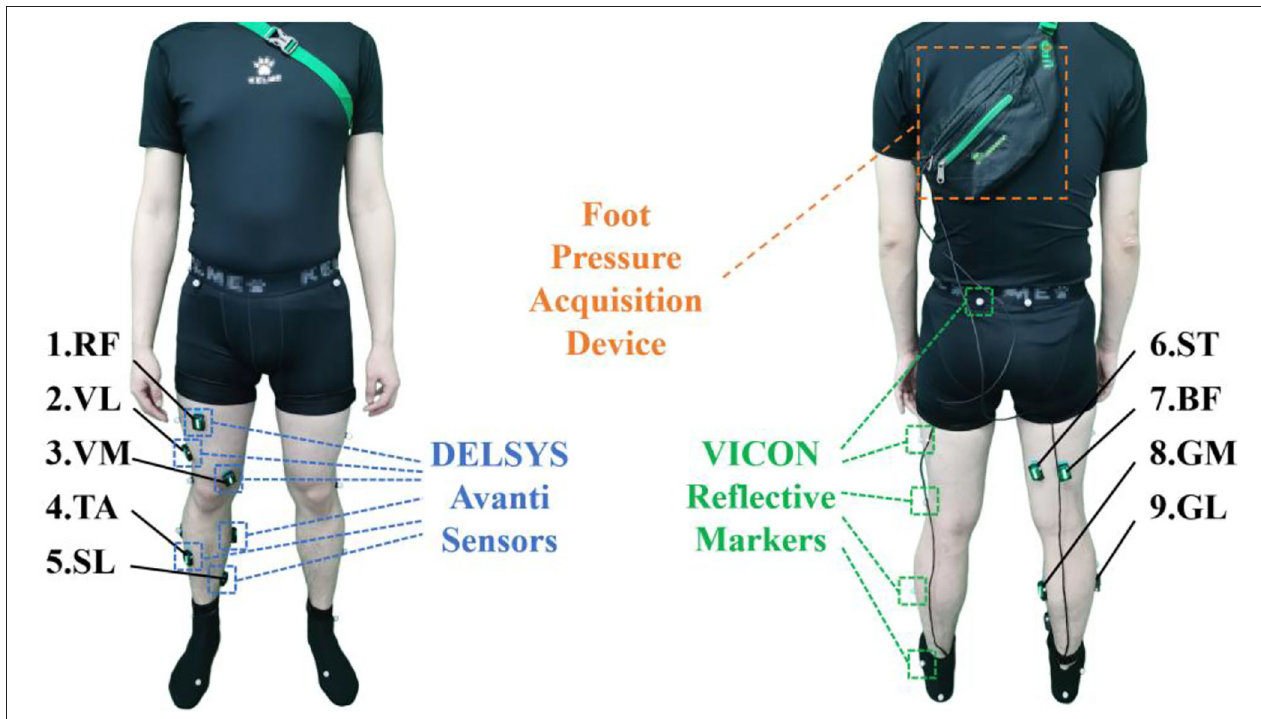
FIGURE 2 | Sensor attachment of the subjects.